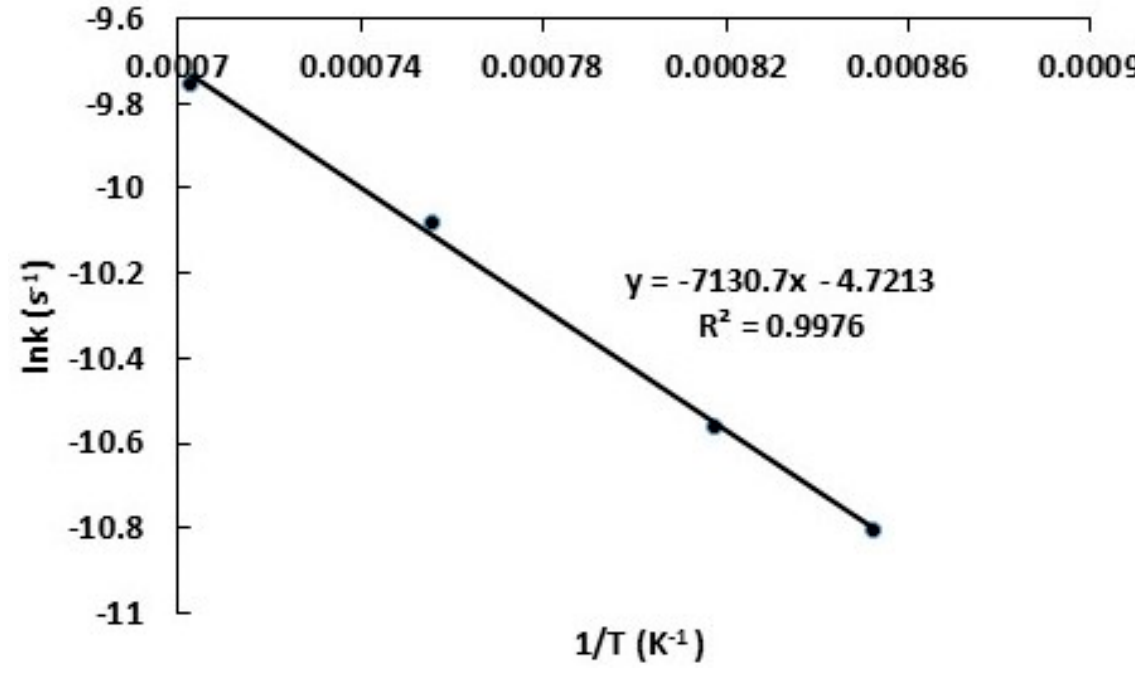
Figure 8. Arrhenius plot for barium sulfate conversion in the compacted sample.